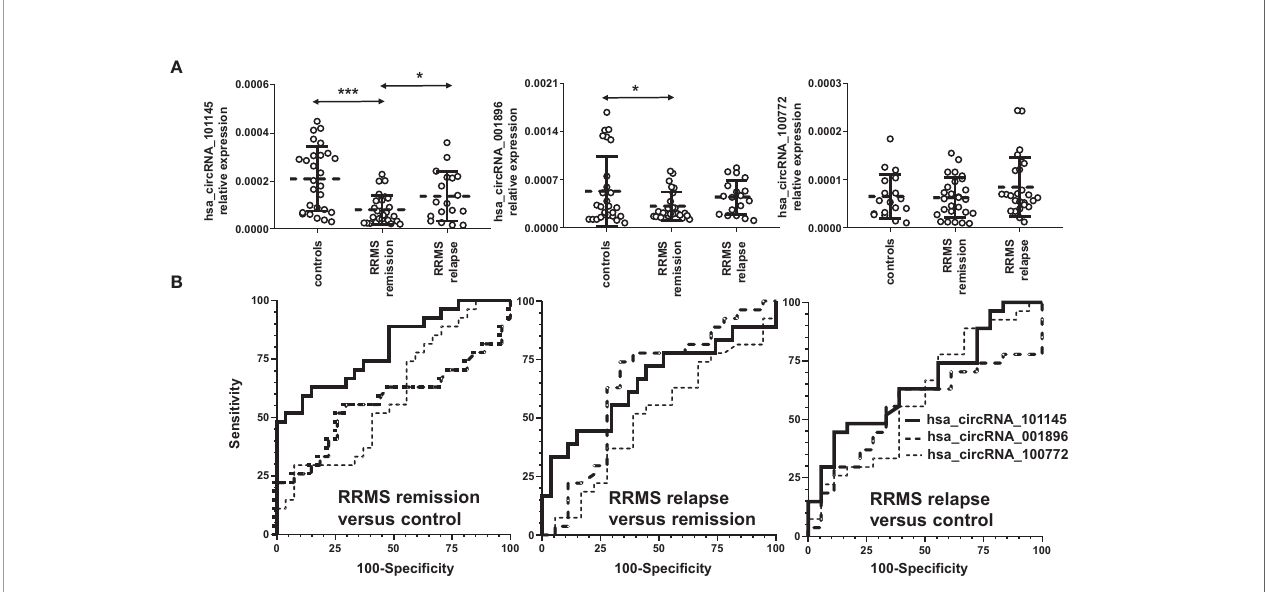
FIGURE 2 | Validation of the differential downregulation of the selected circRNAs in RRMS. (A) The expression levels of the indicated circRNAs were analyzed via qRT-PCR. Signi fi cance was determined by analysis of variance (ANOVA) with the Scheffe ́ post-hoc test. * P < 0.05, *** P < 0.0005. The dotted line represents the mean value ( ± SD). (B) Receiver operating characteristic (ROC) curves for the comparison of hsa_circ_101145, hsa_circ_001896, and hsa_circ_100772 expression levels in RRMS relapse versus control, RRMS remission versus control, and RRMS relapse versus remission.